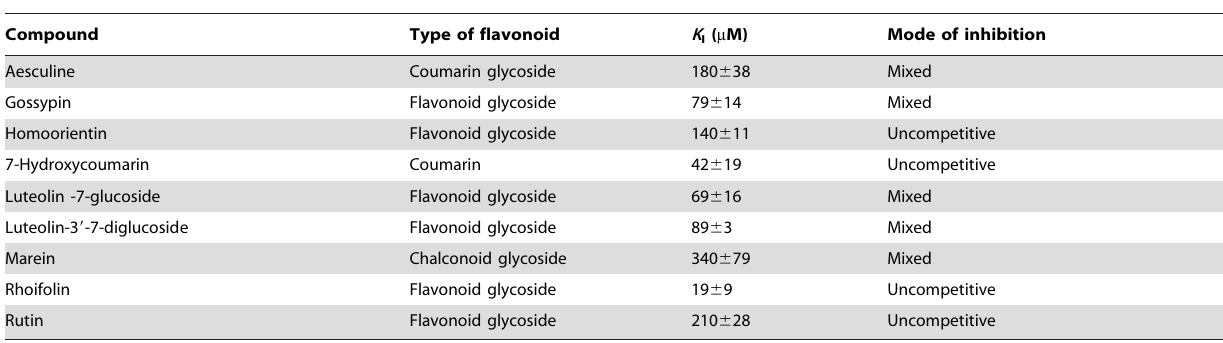
Table 3. efDHQase inhibition constants ( K I